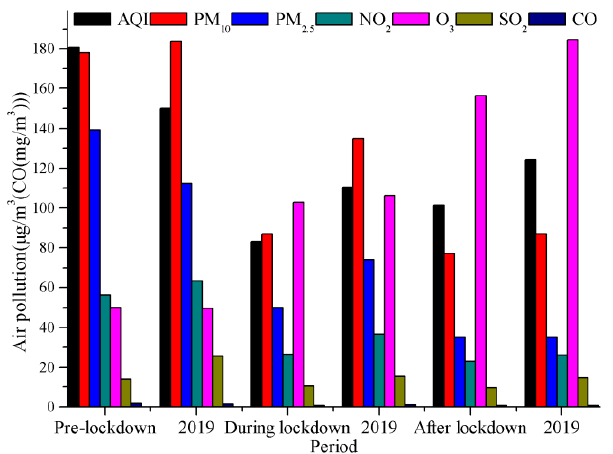
Figure 5. Air quality changes before, during, and after lockdown in 2020 (and the same period in 2019) (unit: μ g/m 3 (CO (mg/m 3 )).